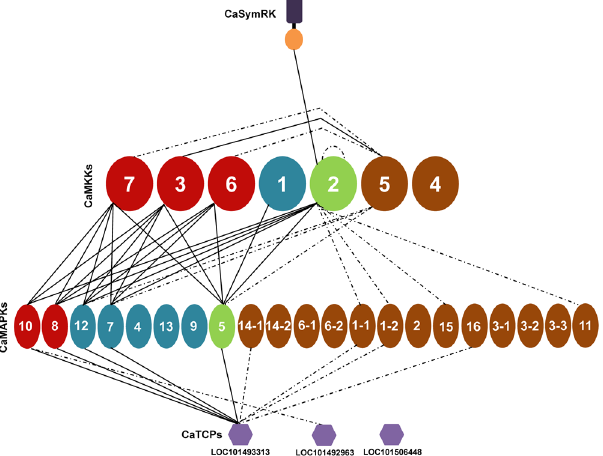
Figure 6. Schematic representation of identified chickpea MKK-MAPK-TCP network. The interactions observed in the study have been graphically represented. The different groups of MKKs and MAPKs have been given different shades for easier visualization. Interactions that have been identified by yeast two-hybrid and verified in planta by bimolecular fluorescence complementation (BiFC) are represented by solid lines while those checked through reciprocal yeast two-hybrid assays only are represented by dotted